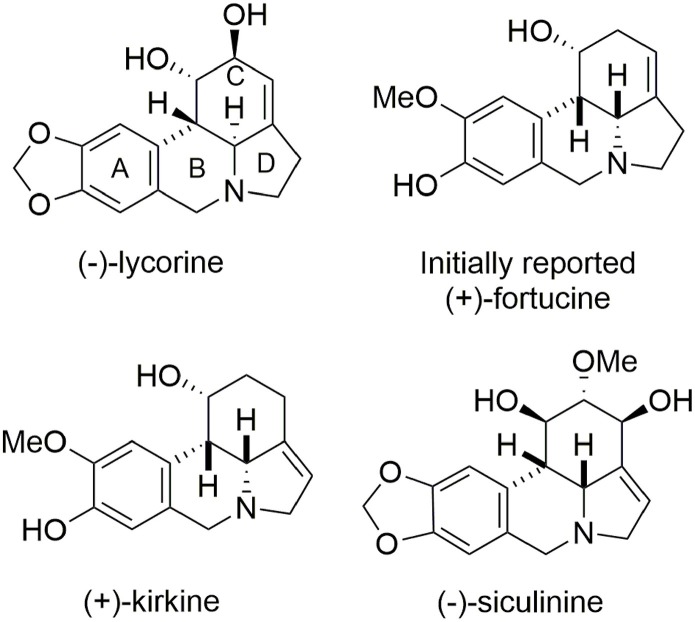
Lycorine alkaloids.